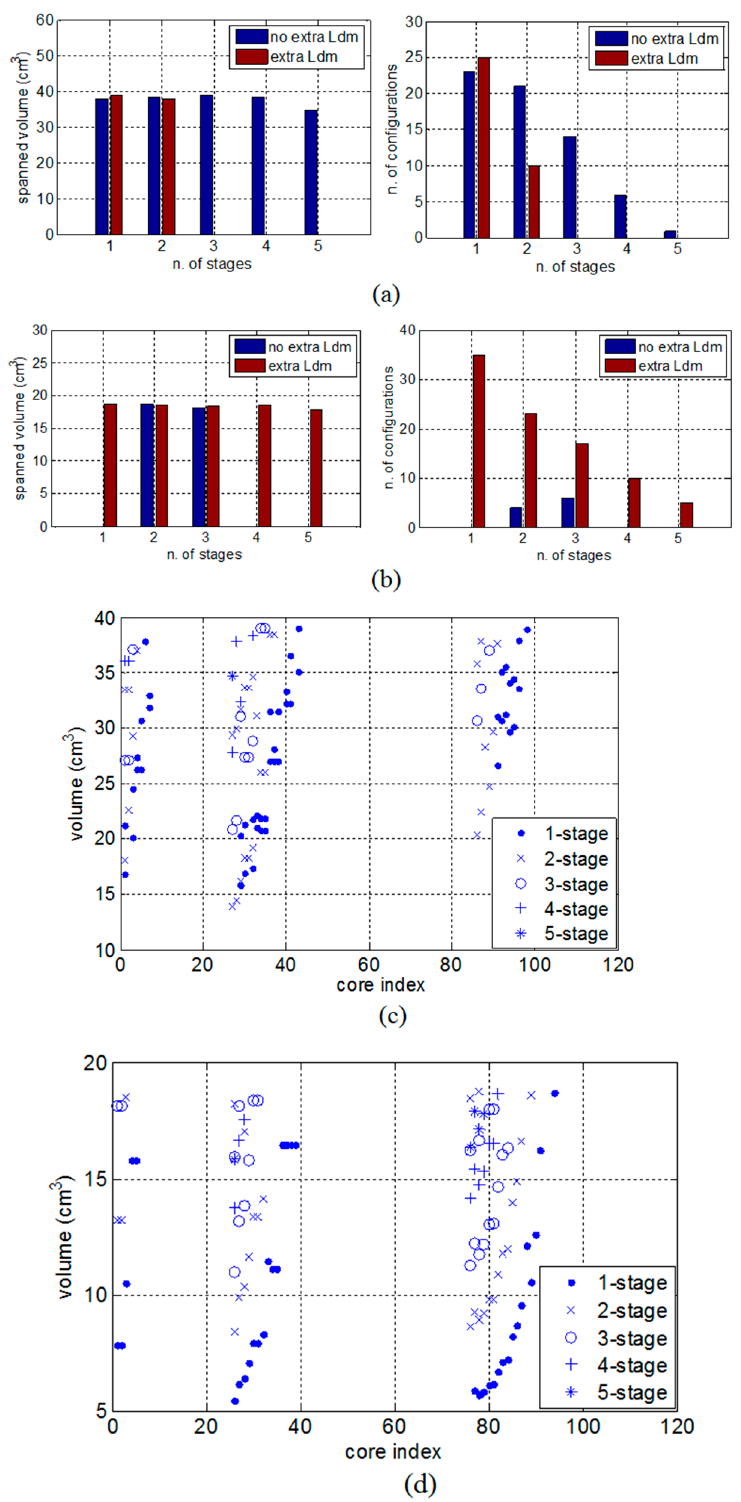
Figure 6. Scatter plot and distribution of the best 100 configurations in case study #1 ( a , c ) and in case study #2 ( b , d ).